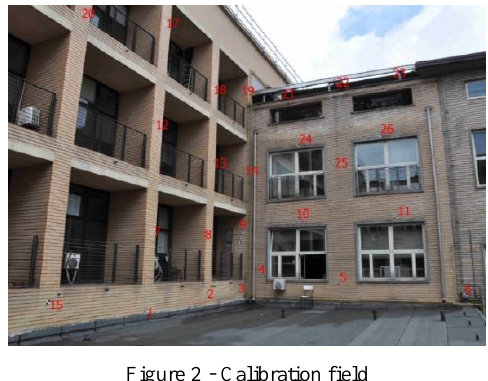
Figure 2 - Calibration